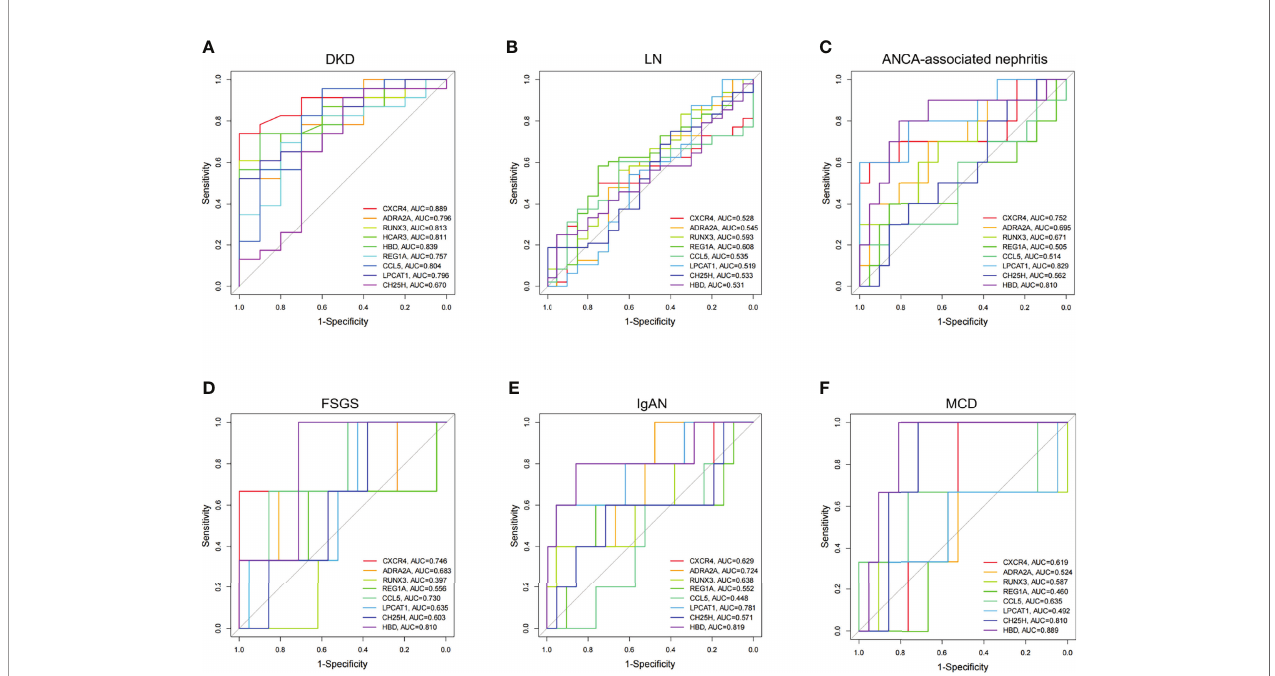
FIGURE 4 | Diagnostic ef fi cacy of DEGs expressed consistently between blood and kidney in CKD. (A) Multivariate ROC curve of DEGs in DKD (GSE142153). (B – F) Multivariate ROC curve of DEGs in LN, ANCA-associated nephritis, FSGS, IgAN, and MCD, respectively (GSE72326). LN, lupus nephritis; ANCA, Anti- Neutrophil Cytoplasmic Antibodies; FSGS, focal segmental sclerosis; IgAN, IgA nephropathy; MCD, microscopic disease.